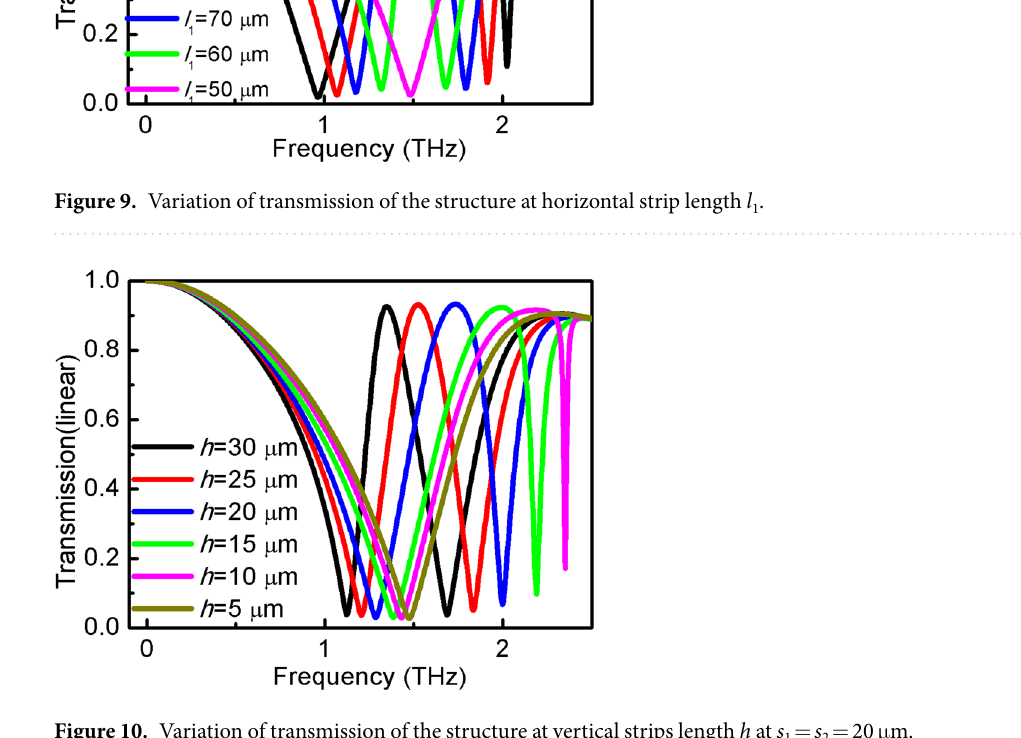
Figure 10. Variation of transmission of the structure at vertical strips length h at s 1 = s 2 = 20 μ